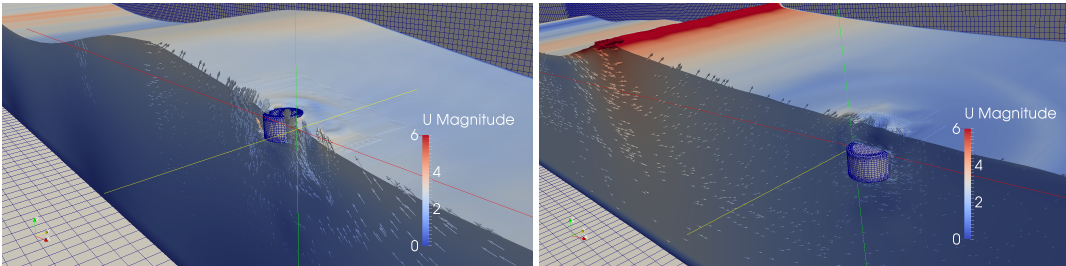
Figure 17. The WEC impacted by a regular wave ( left ), and by a tsunami wave ( right ). The incident waves are traveling from the left to the right in the figures. The connection line length is modelled as too short in those simulations. The origin marks the original position of the buoy in still